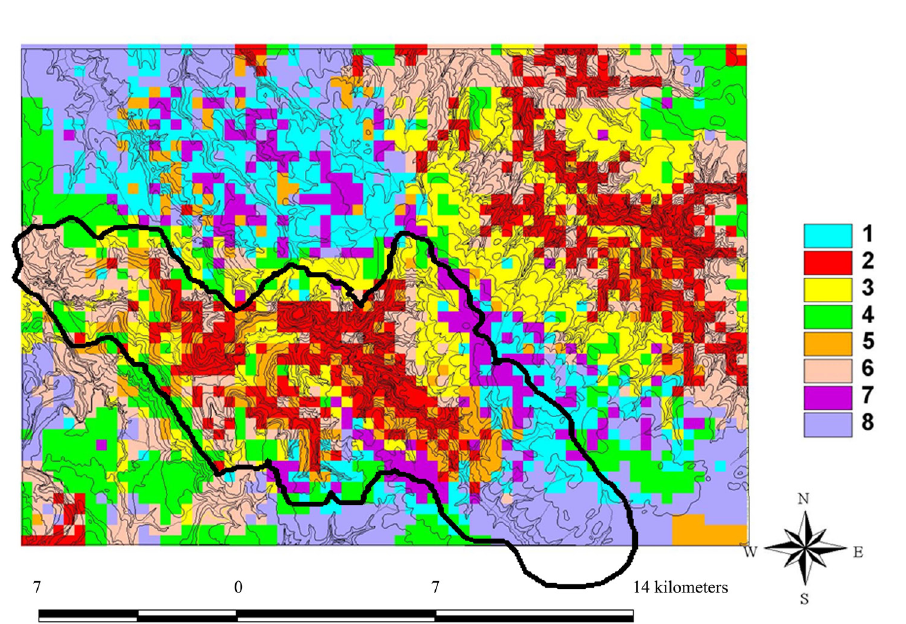
Figure 5: Multiscale cartographic model of the most probable soil-vegetation WS-classes based on water-sensitive properties. Bold black curve – boundary of the Zayachya river